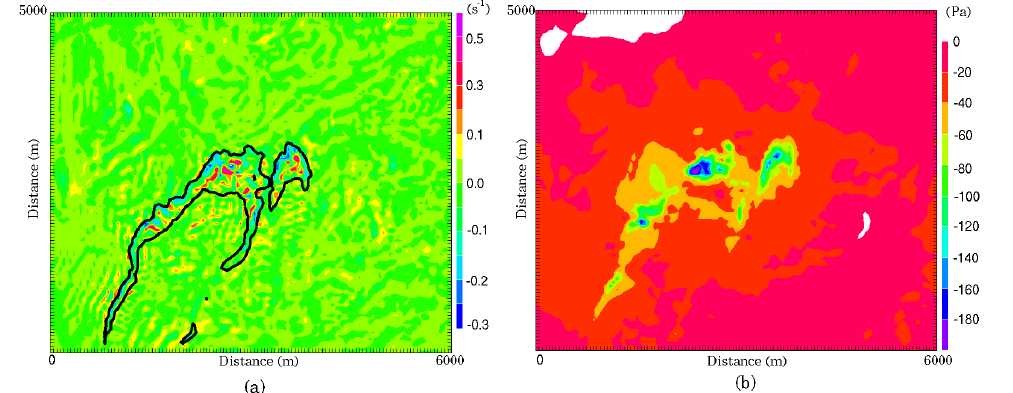
Figure 11. Difference between “coupled” and “uncoupled” simulations on 23 July 2009 at 1500 UTC: Horizontal cross-sections of ( a ) 10-m horizontal divergence (in s − 1 ) with the fire tracer superimposed (in black); ( b ) 10-m pressure (in